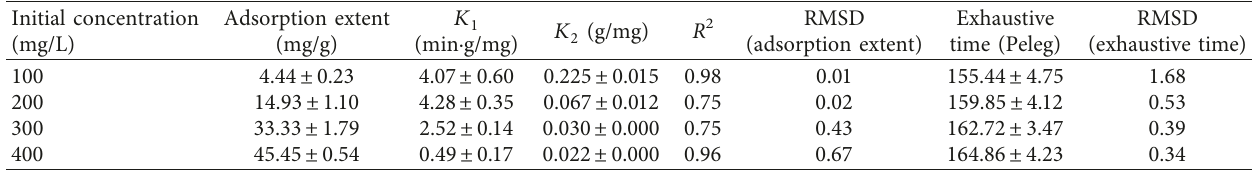
Table 2: Values of adsorption extent, Peleg’s constants ( K root mean squared deviation (RMSD) at different initial